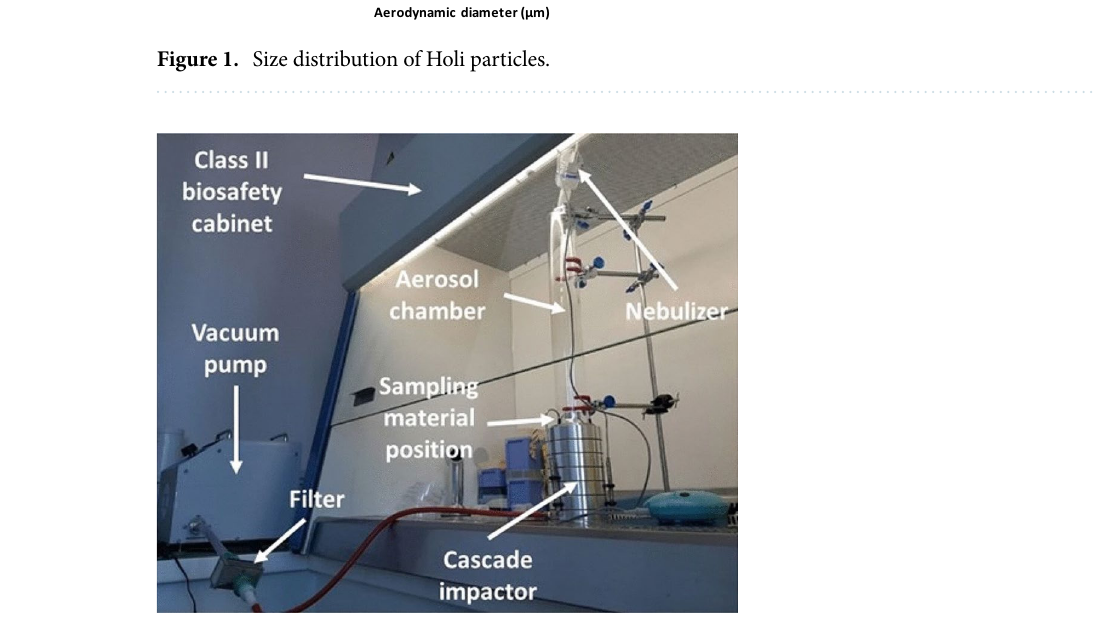
Figure 2. BFE experimental set-up developed by CIS of Mines